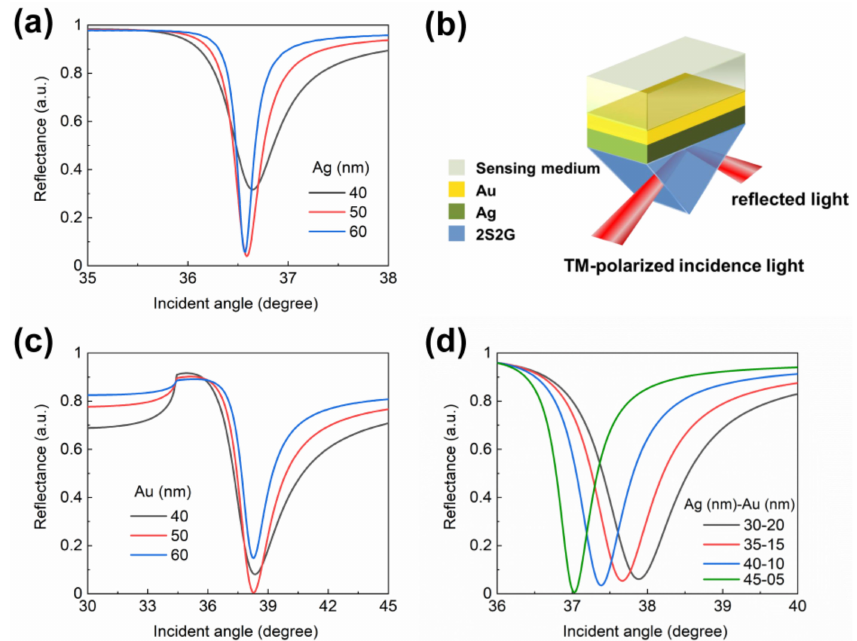
Figure 2. Surface plasmon resonance curves at a wavelength of 633 nm of sensors containing ( a ) an Ag film. ( b ) The structure of the SPR sensor based on the Kretschmann configuration. The refractive index of the sensing medium layer is 1.33. ( c ) an Au film, and ( d ) both Ag and Au films of different